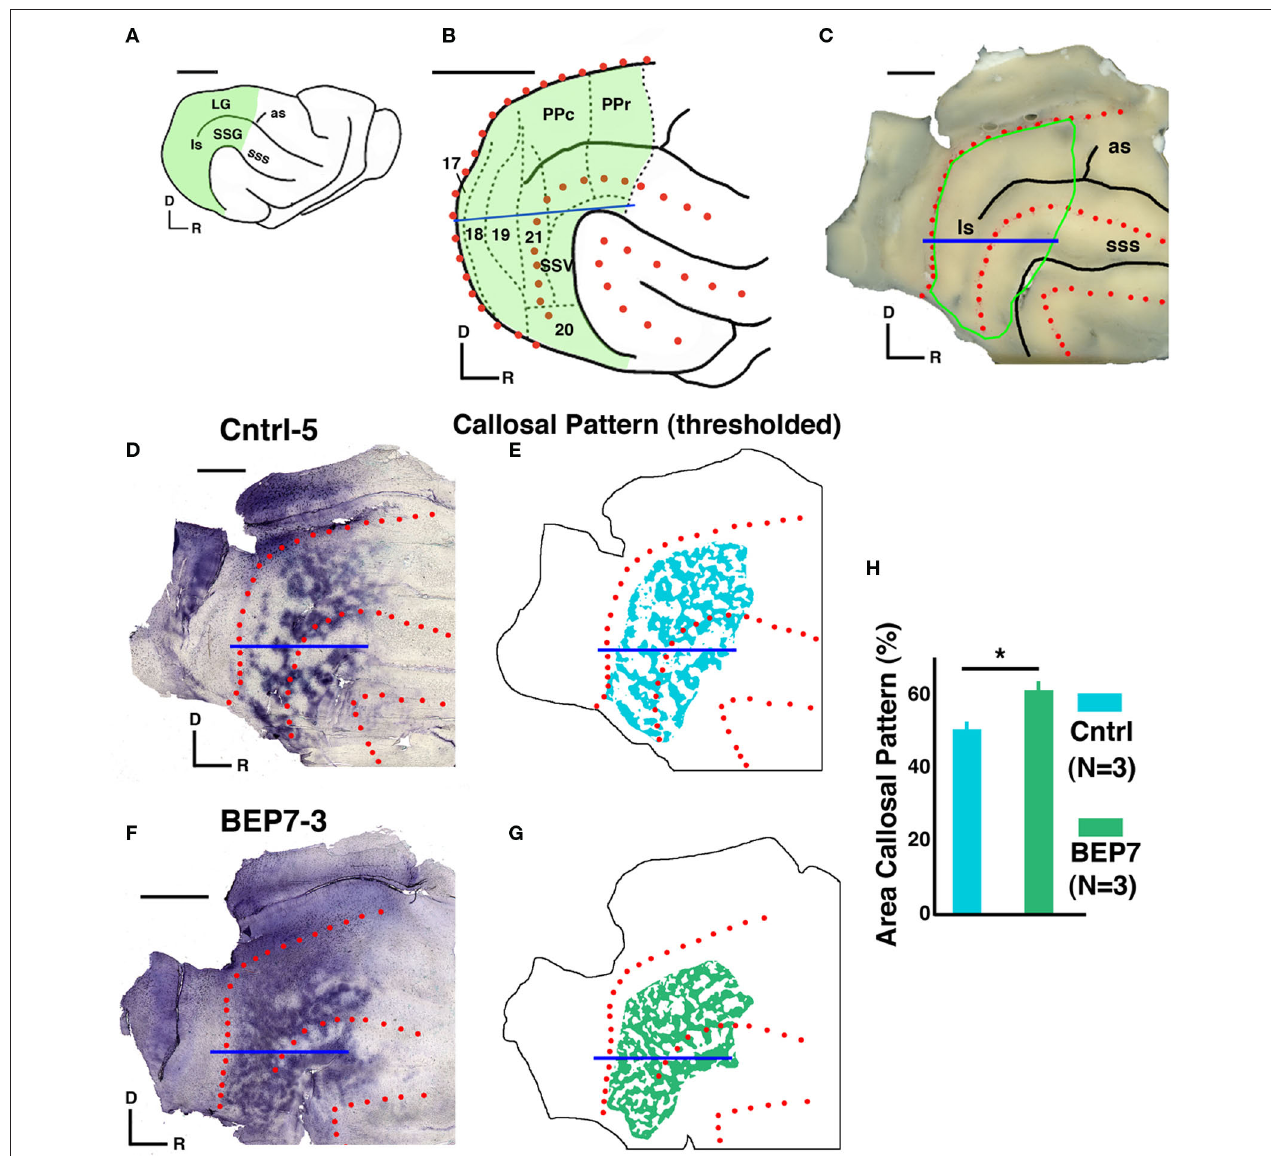
FiGure 1 | effect of bilateral enucleation on postnatal day 7 (BeP7) on the distribution of interhemispheric visual callosal connections in the ferret. The distribution of callosal connections in one hemisphere of adult BEP7 and control ferrets were studied following multiple intracortical injections of the tracer HRP in the contralateral hemisphere. Green areas in (A) and (B) include regions of visual cortex analyzed. Approximate locations of visual areas described in previous reports are indicated in (B) ; the blue line marks the representation of the horizontal meridian. Red dots indicate the crown of the suprasylvian and ectosylvian and gyri, and the dorsal/caudal edge of the occipital